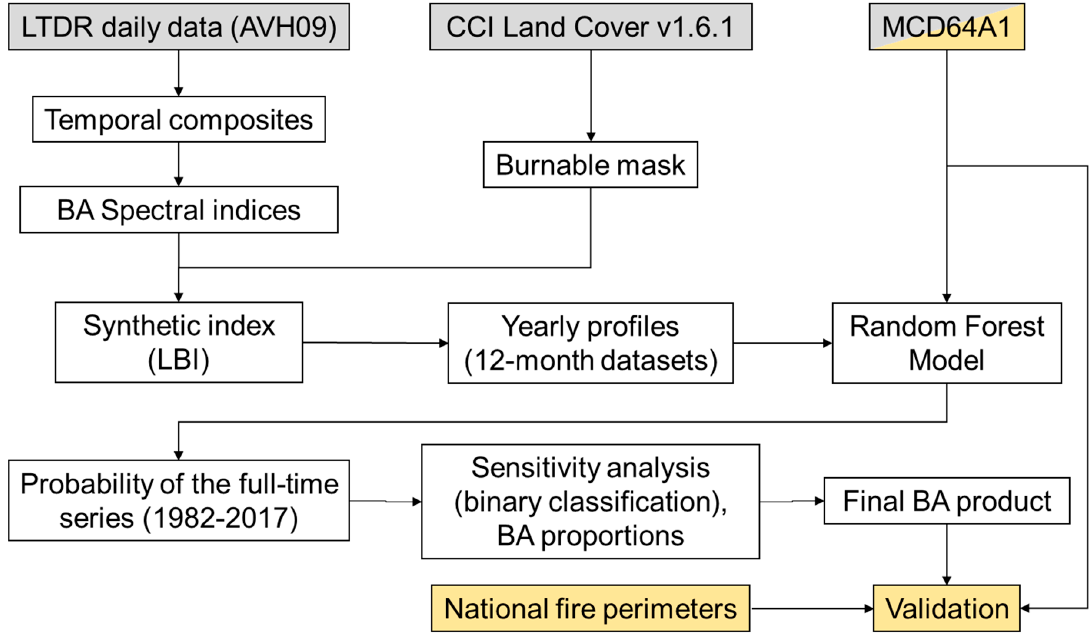
Figure 1. Flowchart of the methodology to obtain the FireCCILT10 BA product. The method starts with the input data (shown in grey), which are processed and converted into a BA classification. This product is validated independently in the validation step (shown in light orange).